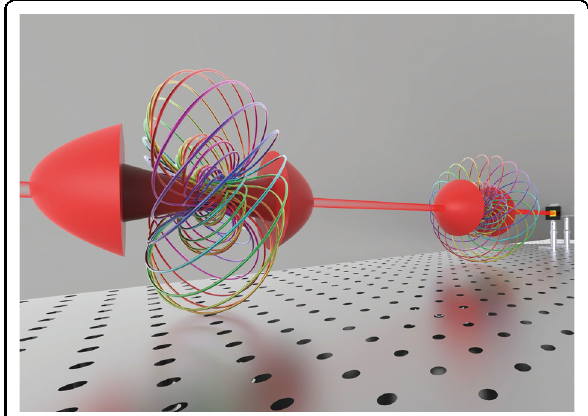
Fig. 1 Schematic of the Hopf fi bration and scalar hop fi on by spatiotemporal beam shaping. The equiphase lines in a scalar hop fi on present the topological features of the Hopf fi measured poloidal phase distributed in a spiral pattern in the spatiotemporal domain is well consistent with the theoretical predictions.